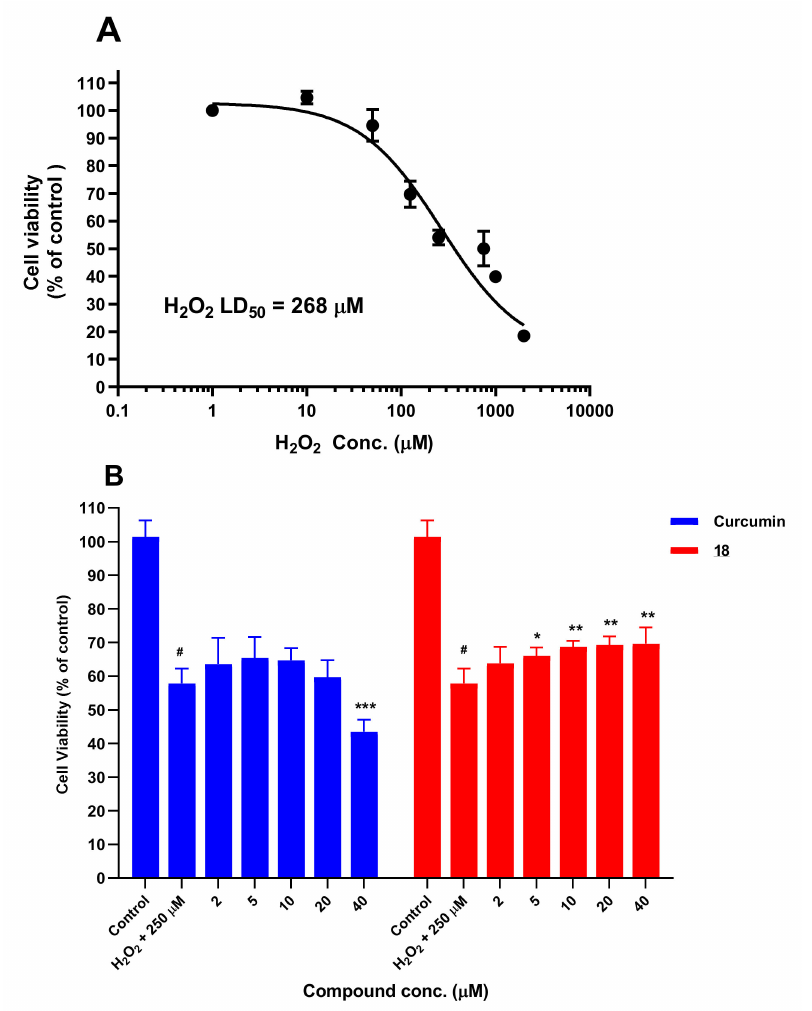
Figure 10. ( A ) Determination by the Resazurin method of the H 2 O 2 lethal dose (LD50, µ M) after 24-h incubation of SH-SY5Y cells. Values are the Mean ± SEM of four different experiments carried out in quadruplicate. ( B ) Neuroprotection effect of curcumin and compound 18 against H 2 O 2 -induced cytotoxicity in SH-SY5Y cells. Cell viabilities were determined by Resazurin assay with fluorometric detection. Compounds were administered at different concentrations for 24 h prior to H 2 O 2 250 µ M treatment for another 24 h. Data are presented as the Mean ± SEM of four independent experiments carried out in quadruplicate. # p < 0.001 vs. vehicle-treated control. * p < 0.05, ** p < 0.01, *** p <0.001 vs. only with H 2 O 2 -treated